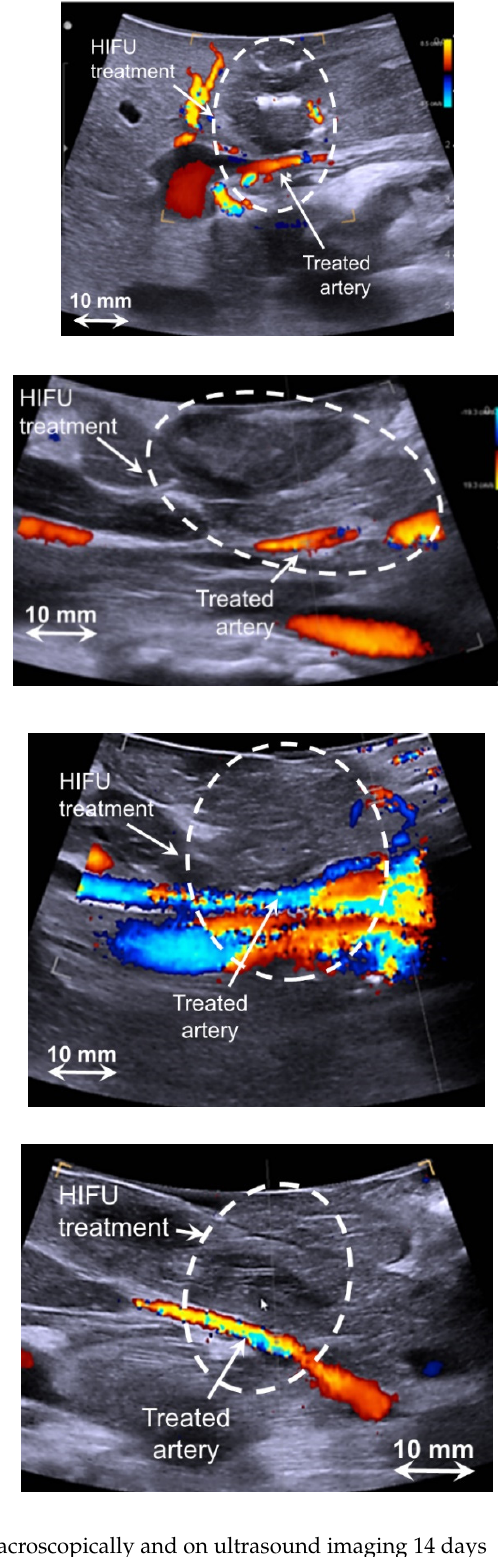
Figure 4. Typical examples for each group of HIFU ablations observed macroscopically and on ultrasound imaging 14 days after treatment.